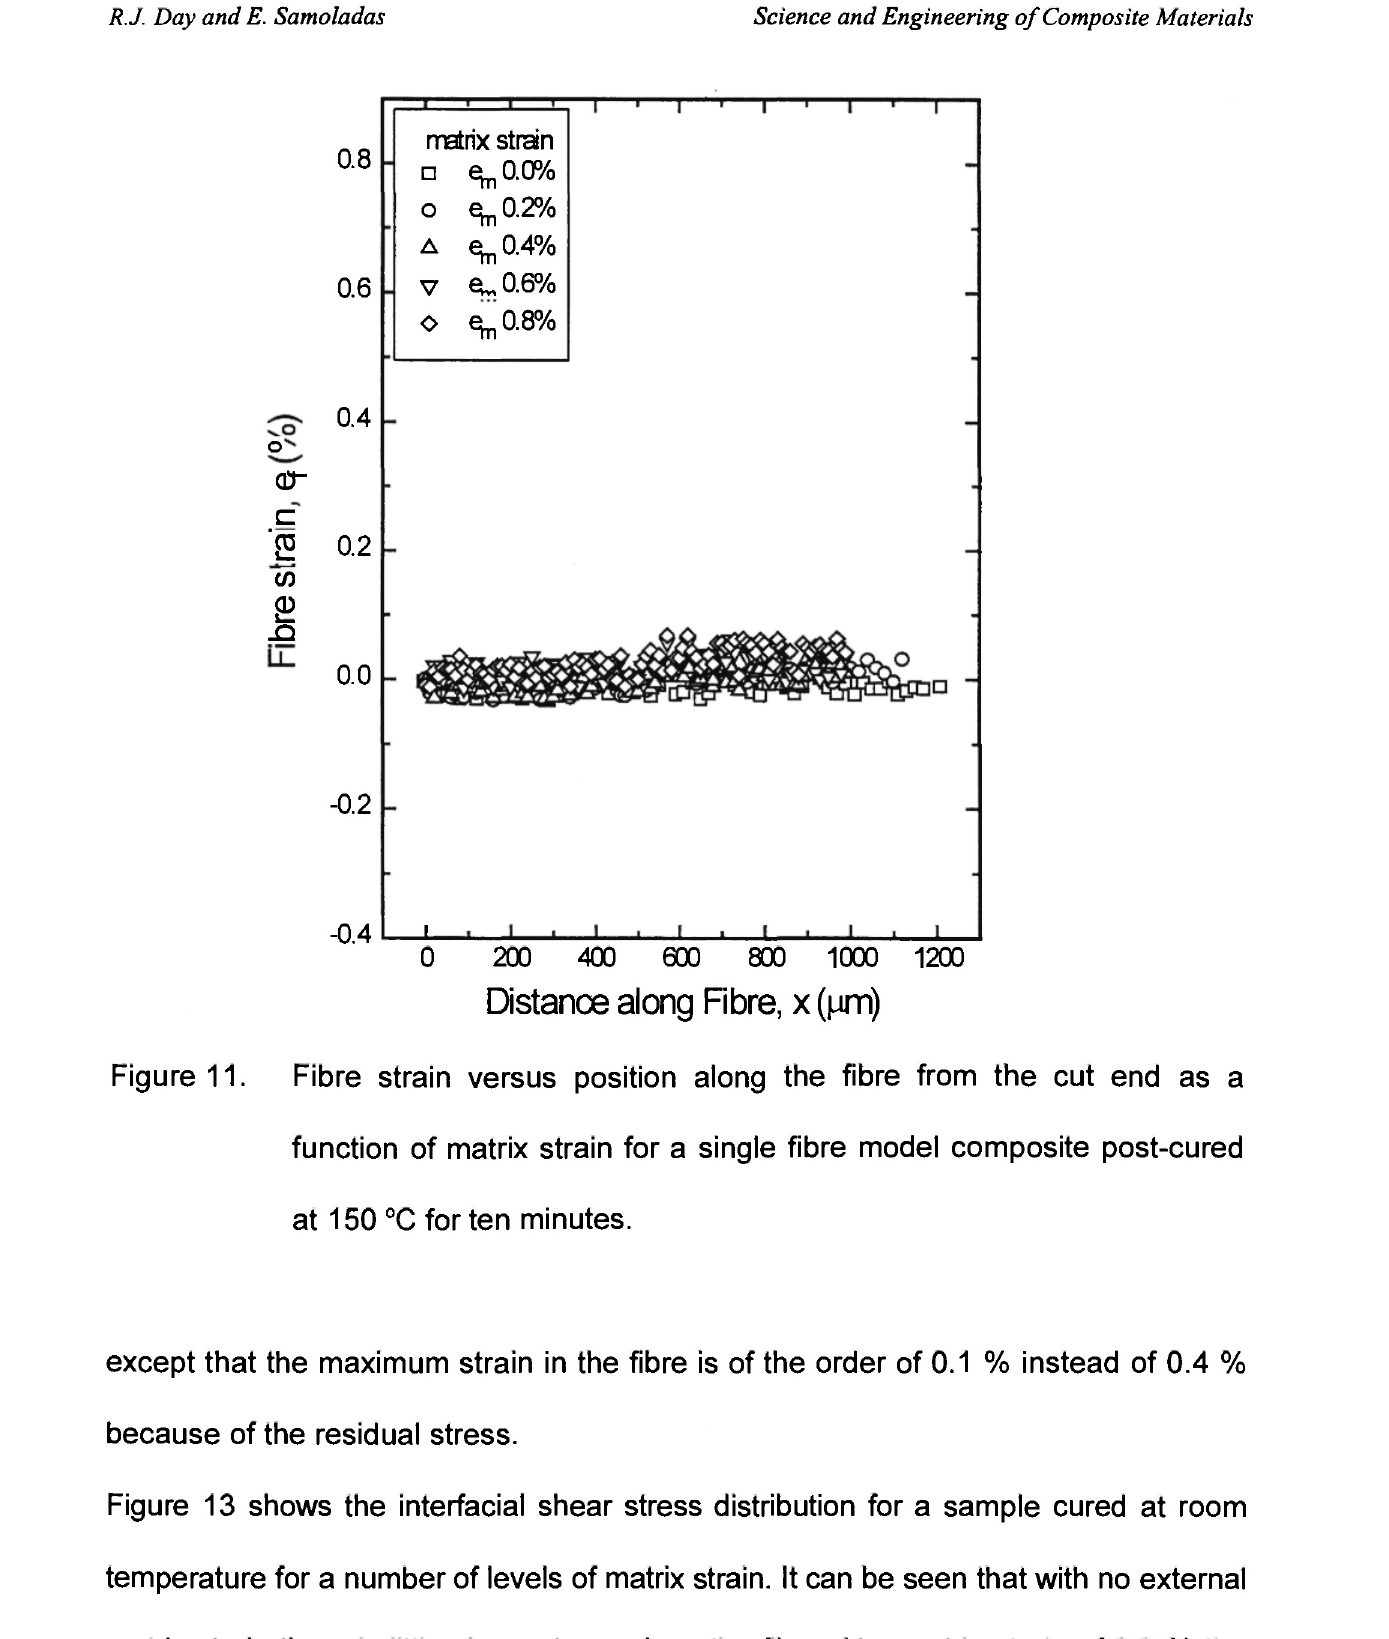
FigureH. Fibre strain versus position along the fibre from the cut end as a function of matrix strain for a single fibre model composite post-cured at 150 °C for ten